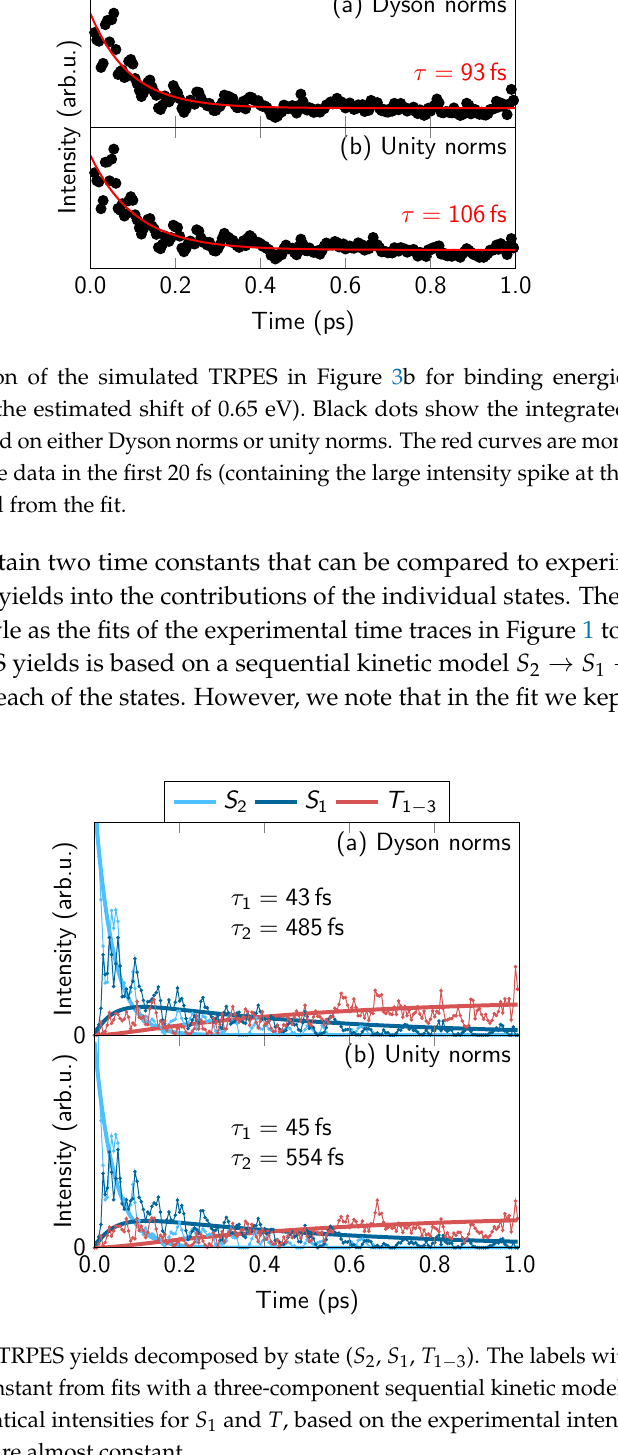
3 ). The labels within the plots give −